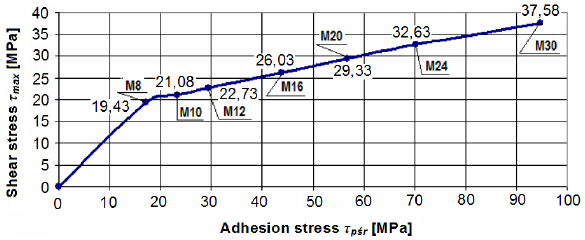
Figure 16: Dependency shear stress – adhesion stress for M8 ÷ M30 anchors in the stairwell slab.